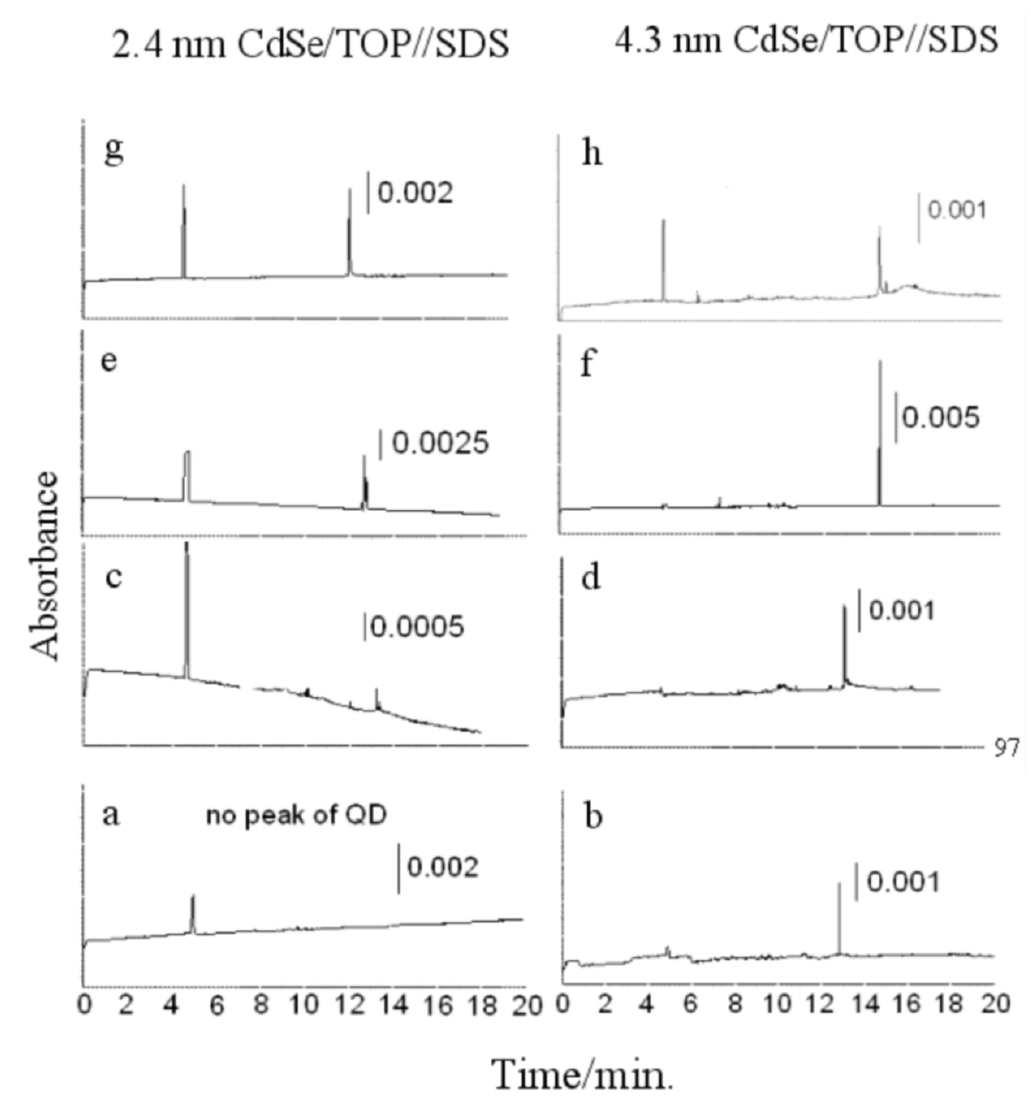
Figure 7. Formation of stable SDS-coated CdSe/TOPO QDs as observed by CZE. Sample preparation: (a, b) 50 mM SDS, no peak was observed for 2.4 nm QD; (c, d) 100 mM SDS; (e, f) 250 mM SDS; (g, h) 500 mM SDS. Sample preparation according to Section 2.4. Run buffer: 20 mM Na applied voltage +20 kV; (a-f) 35 mbar, 5 s; (g, h) 20 mbar, 2 s. The latter was reduced to keep the peak height on